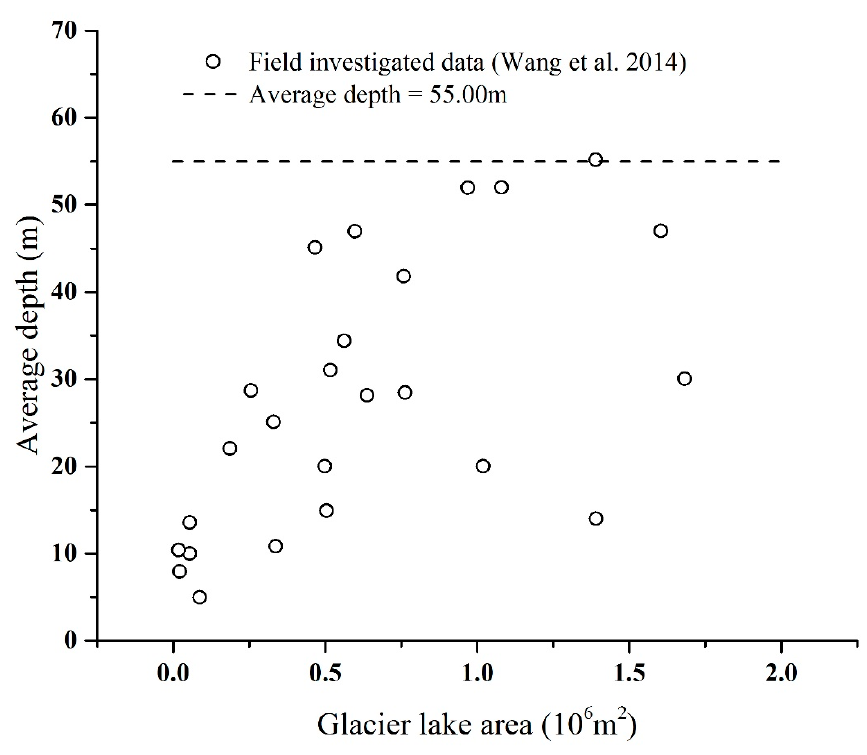
Figure 9. Relationship between moraine lake area and average depth.